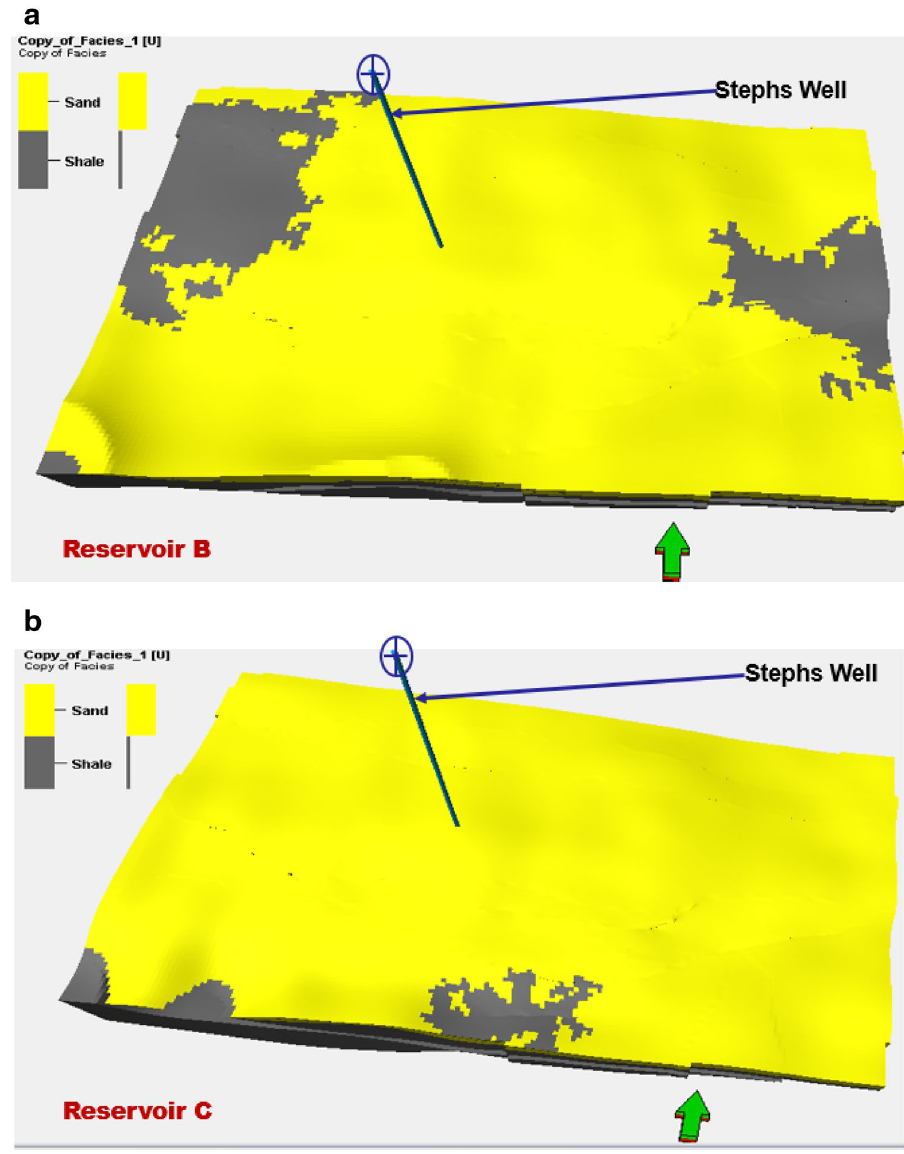
Fig. 10 a Lithofacies model for reservoir B. b Lithofacies model for reservoir